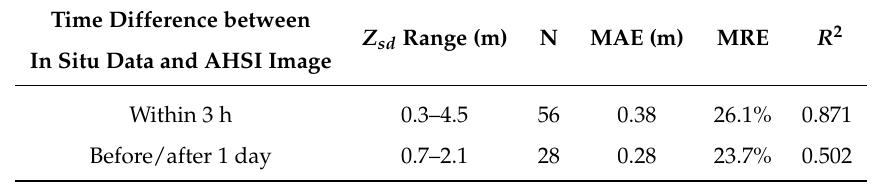
Table 5. AHSI image-derived Z sd accuracies for the 56 samples collected on the same day as the image acquisition, and 28 collected before/after one